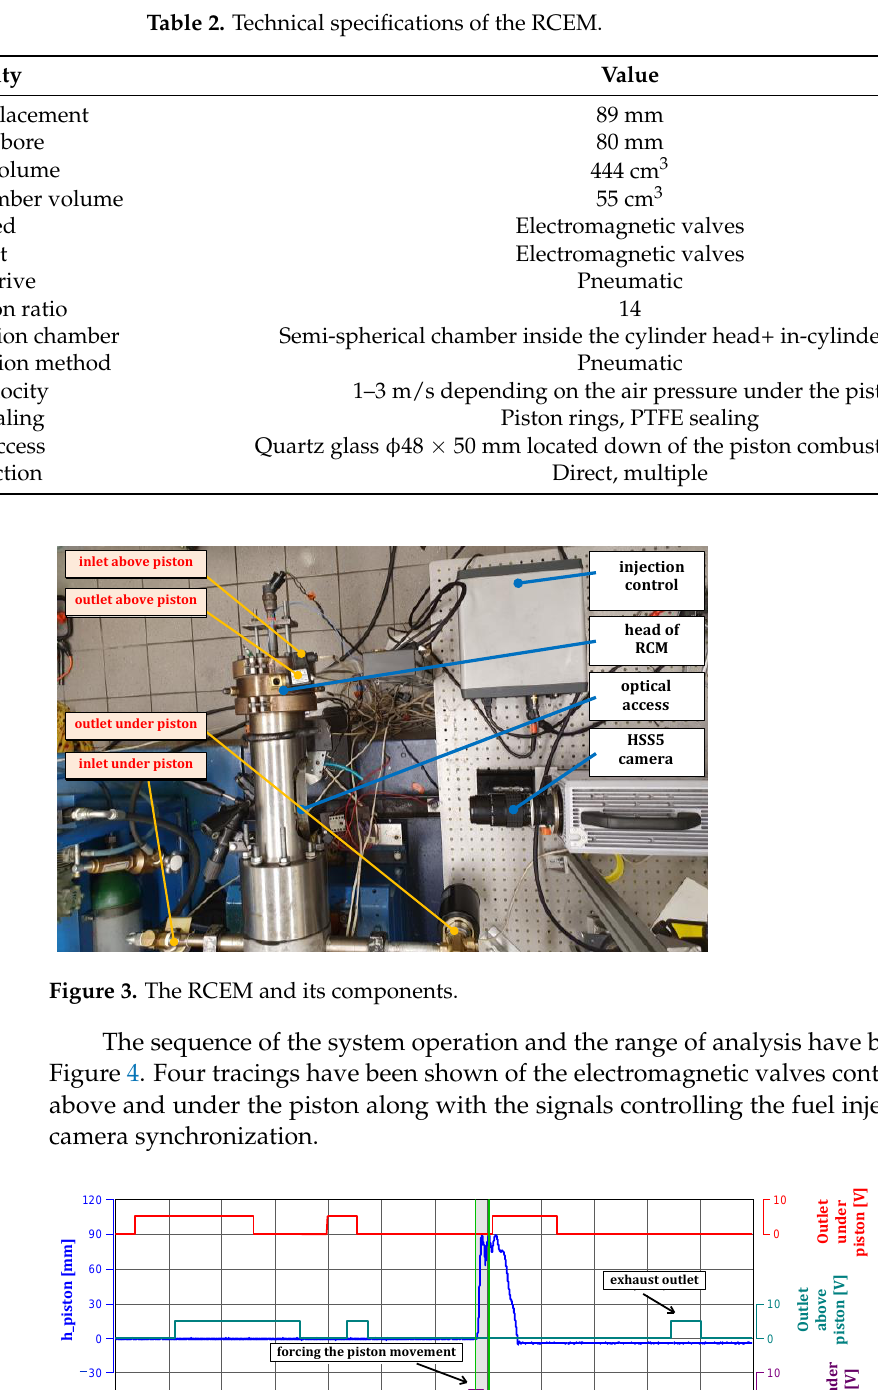
Table 2. Technical specifications of the RCEM